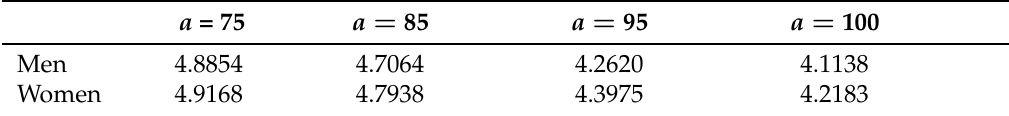
Table 4. Estimates of a single annuity premium ( ρ a ) for r = 0.2 and year 2017, at a = 75,85, 95,100. The probabilities t P a are estimated with the Beta Transformed Kernel Estimator